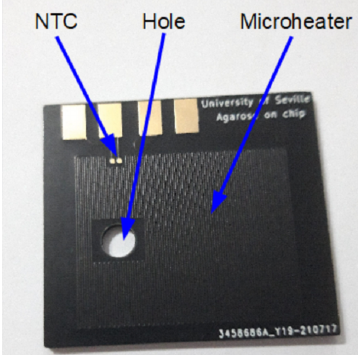
Figure 2. Microheater fabricated using commercially available PCB for agarose gel